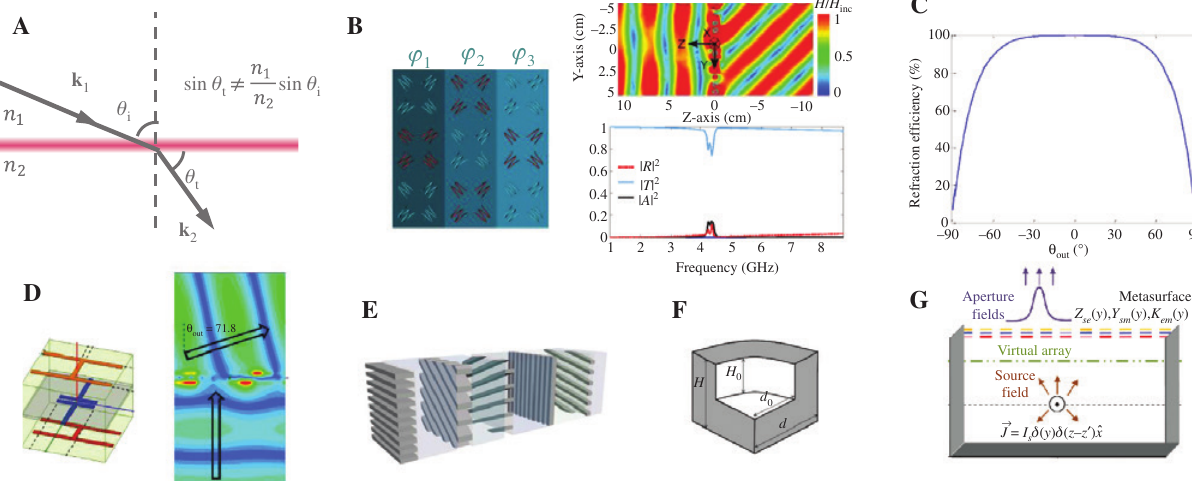
Figure 13: Wavefront manipulation of refracted waves by bianisotropic metasurfaces. (A) Illustrative representation of the anomalous refraction scenario. (B) Huygens’ metasurfaces with controlled bianisotropic response: gradient metasurface for anomalous refraction based on single-wire chiral elements. Since both electric and magnetic dipoles are excited by the same current mode, the metasurface is matched to free space in a very wide frequency range and does not produce reflections. Reprinted figure from [207]. Copyright (2016) by IEEE. (C) Efficiency of linear phase gradient metasurfaces for normal illumination as a func- tion of the refraction angle. Reprinted figure from [13]. Copyright (2016) by the Optical Society of America. (D) Left: Bianisotropic omega inclusion made of three impedance layers as a unit cell of metasurface for perfect anomalous refraction from 0 ° to 80 ° . Right: Electric field distribution from the metasurface. Reprinted figure from [208]. Copyright (2017) by IEEE. (E) Unit cell composed of a stack of silicon gratings with different crystal axes orientations. Reprinted figure from [54]. Copyright (2017) by IEEE. (F) Unit cell composed of a dielectric asymmet- ric nanocylinder (one quarter of the nanocylinder is shown). Reprinted figure from [67]. Copyright (2016) by the Optical Society of America. (G) Conceptual illustration of a low-profile single-feed cavity-excited bianisotropic metasurface antenna, capable of generating an arbitrary desirable field distribution on its aperture. Reprinted figure from [209]. Copyright (2017) by